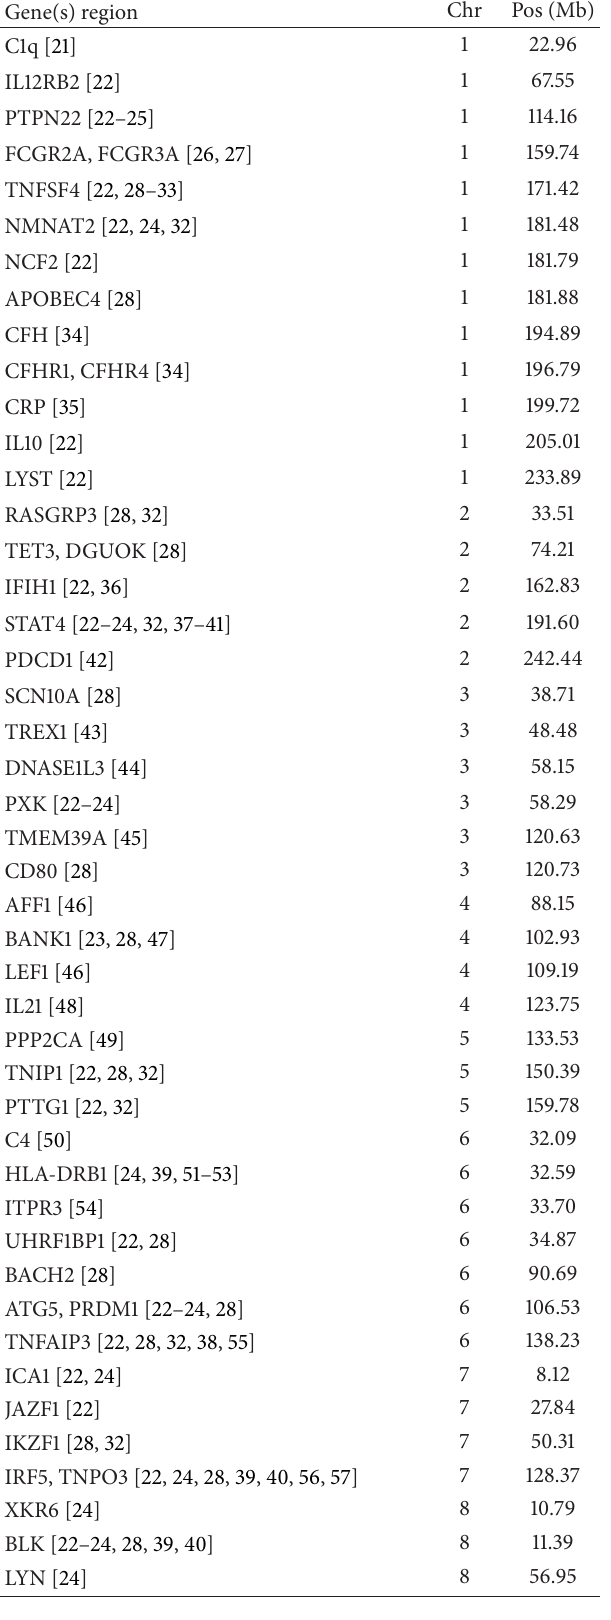
Table 1: Genetic regions with compelling evidence for association with